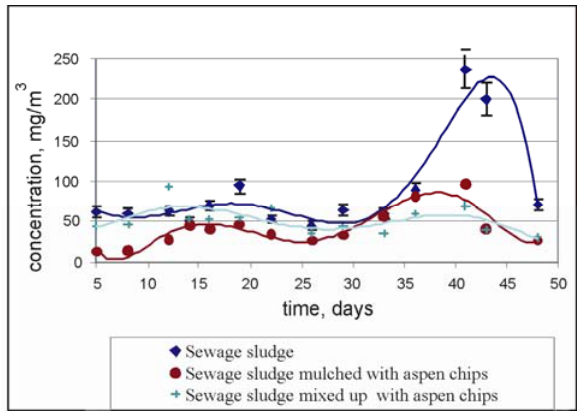
Fig. 6. Ammonia emissions during composting sewage sludge with aspen chips